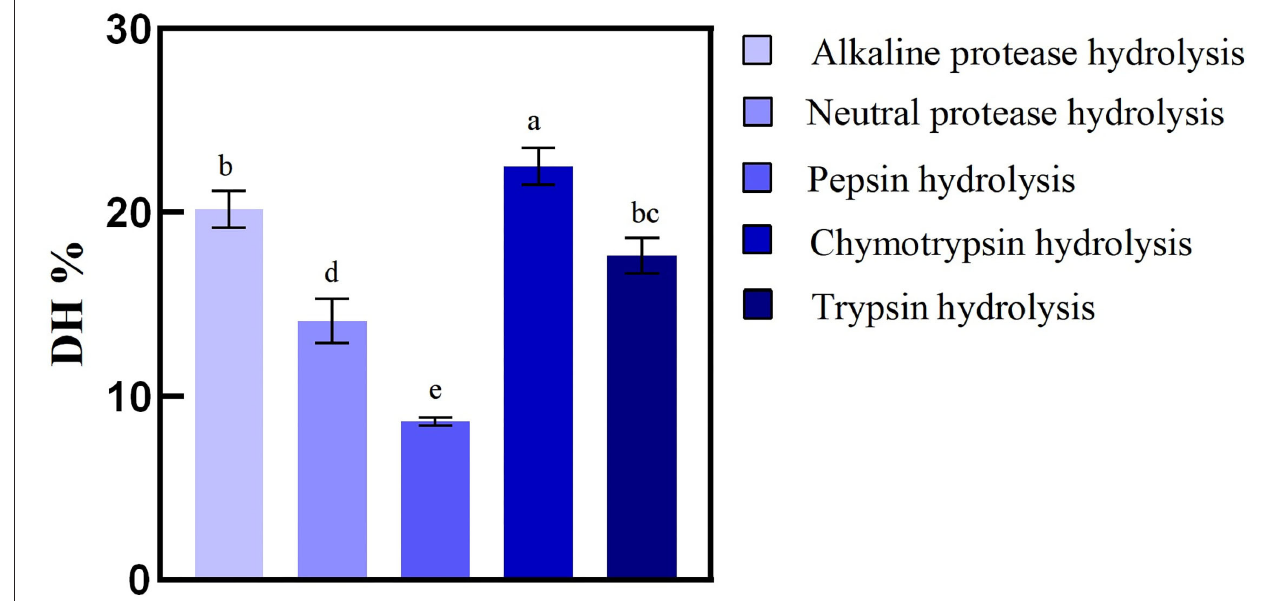
FIGURE 1 | Hydrolysis degree of broken rice by different proteases. Values are shown as mean ± SD ( n = 3). Different letters (a–d) over a bar indicate significant differences ( p < 0.05) in four proteases.